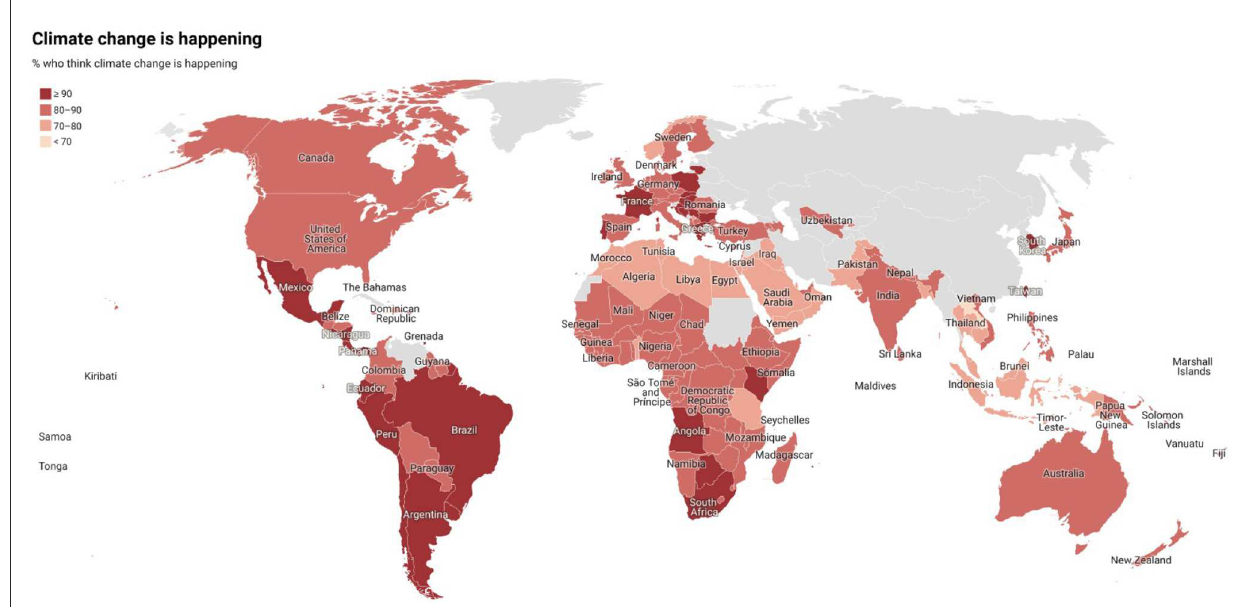
FIGURE6 International public opinion on climate change, 2022. Available online at: https://climatecommunication.yale.edu/publications/international-public- opinion-on-climate-change-2022/toc/3/ (accessed December 15,